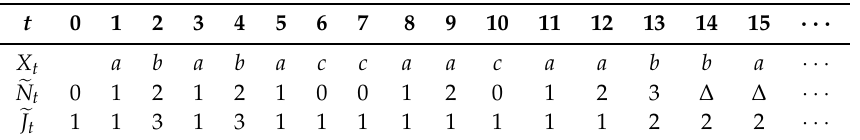
Table 2. Sample paths of (cid:101) N t and (cid:101) J t corresponding to the sample path of X t , ababaccaacaabaa · · · .